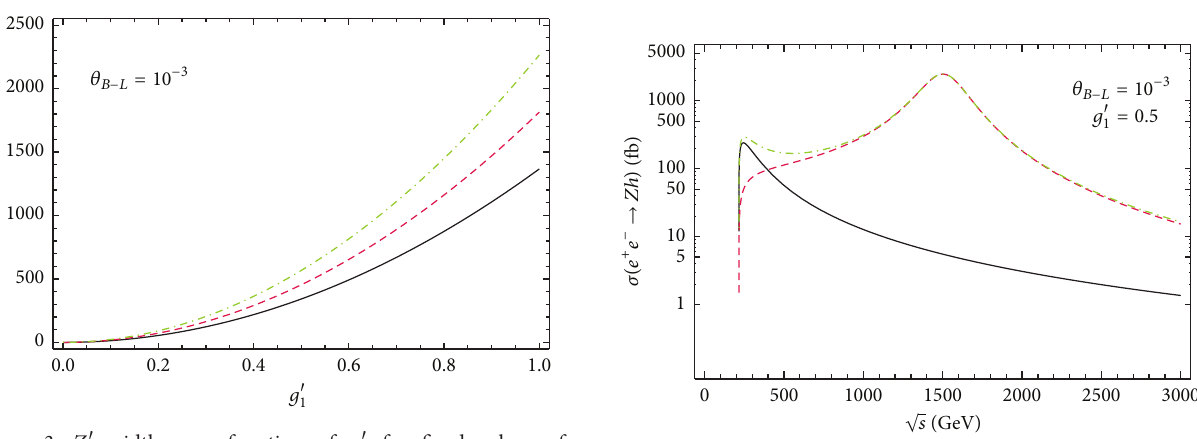
𝑀 = Figure 5: The total cross sections of the production processes 𝑍 󸀠 𝑒 + 𝑒 − → 𝑍ℎ as a function of the collision energy for 𝑀 1500 GeV and 𝑀 ℎ = 125 GeV. The curves are for the first term of (18) (solid line) and second term of (18) (dashed line) and the dot-dashed line corresponds to the total cross section of the process 𝜎(𝑒 + 𝑒 − → 𝑍ℎ) ,